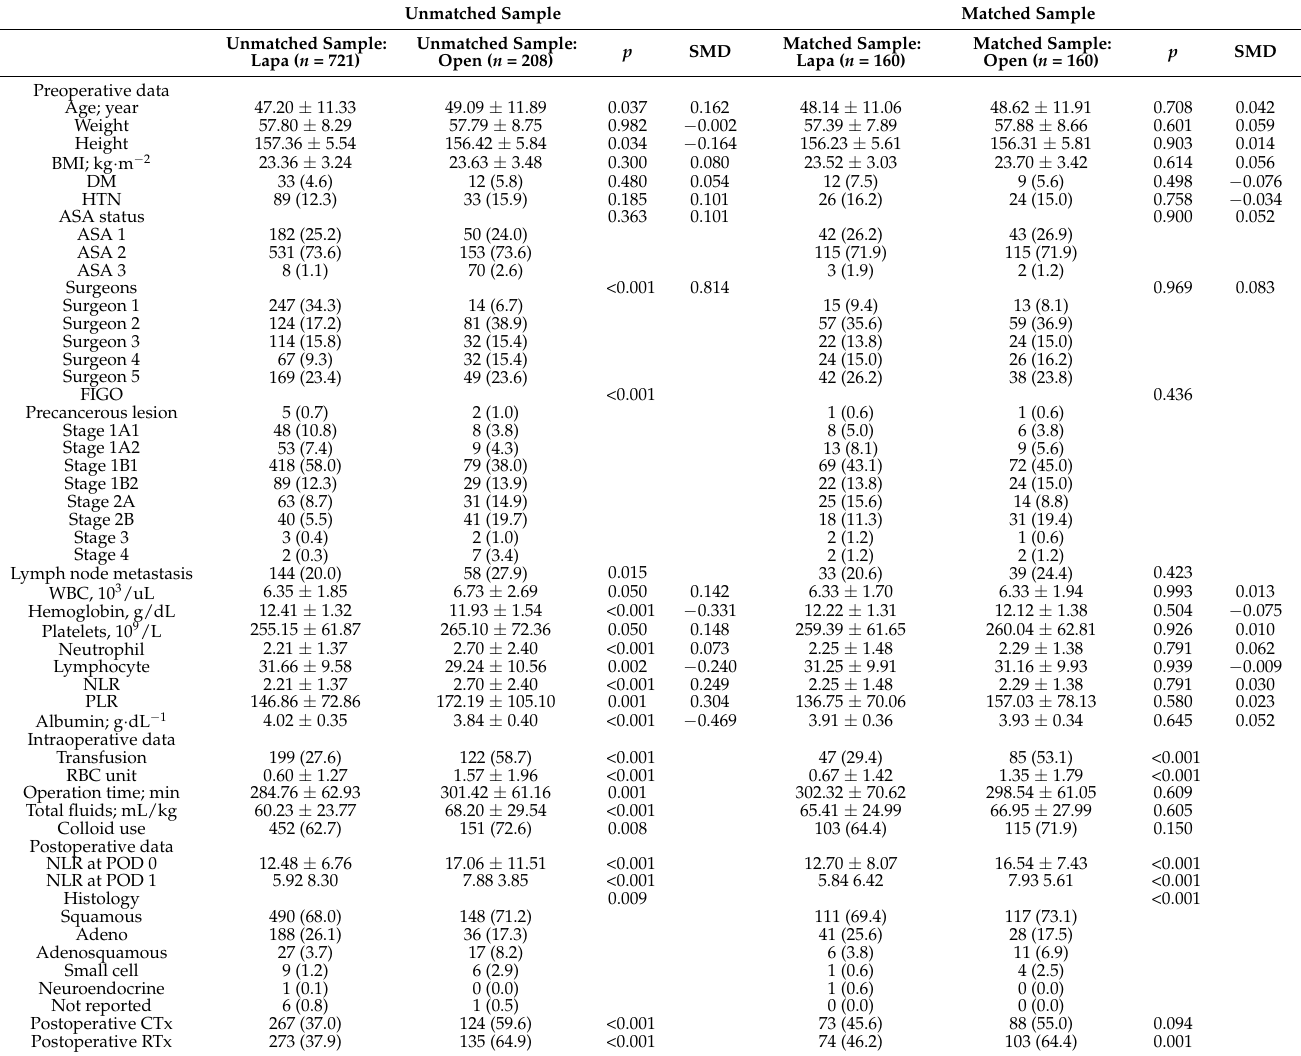
Table 1. Baseline characteristics of the study populations in the unmatched and matched samples. Unmatched Sample Matched